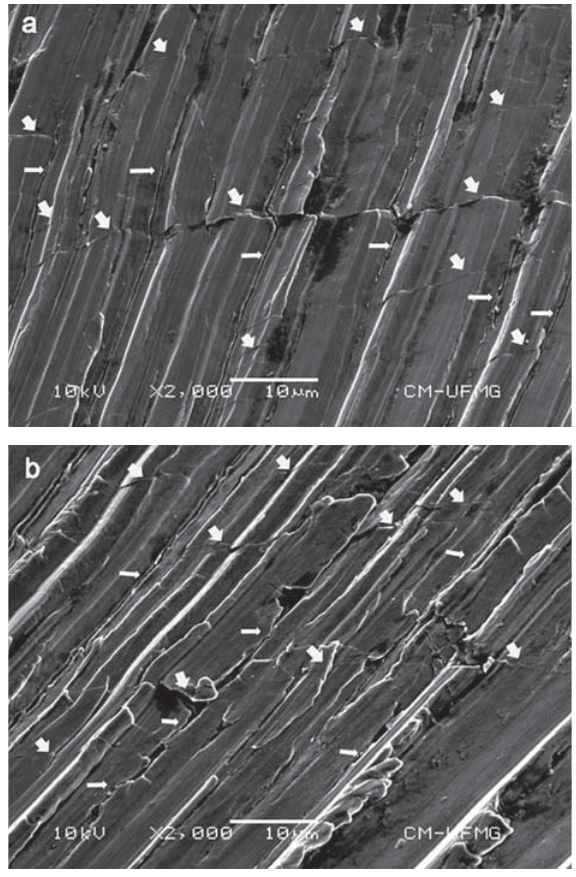
Figure 3- Longitudinal/parallel (wide arrows) and transverse (thin arrows) cracks in Reciproc (a) and WaveOne (b) instruments, respectively, subjected to clinical